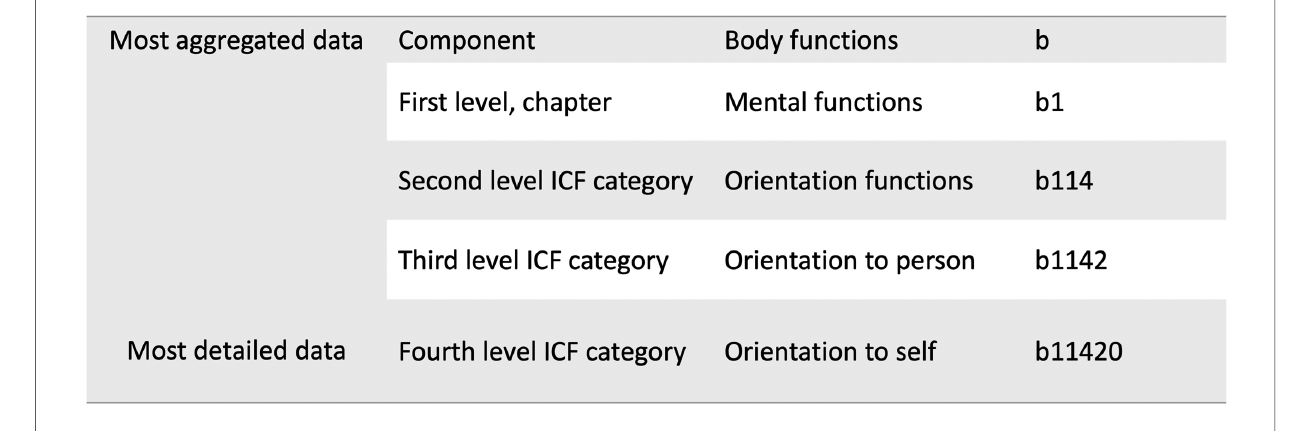
FIGURE 1 Illustration of the hierarchical structure of the international classi fi cation of functioning disability and health, chapter 1 “ Mental functions ”